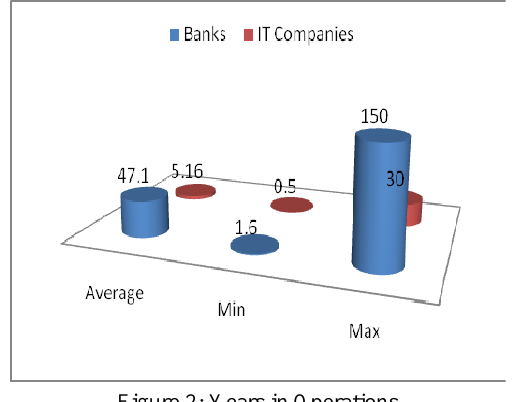
Figure 2: Years in Operations